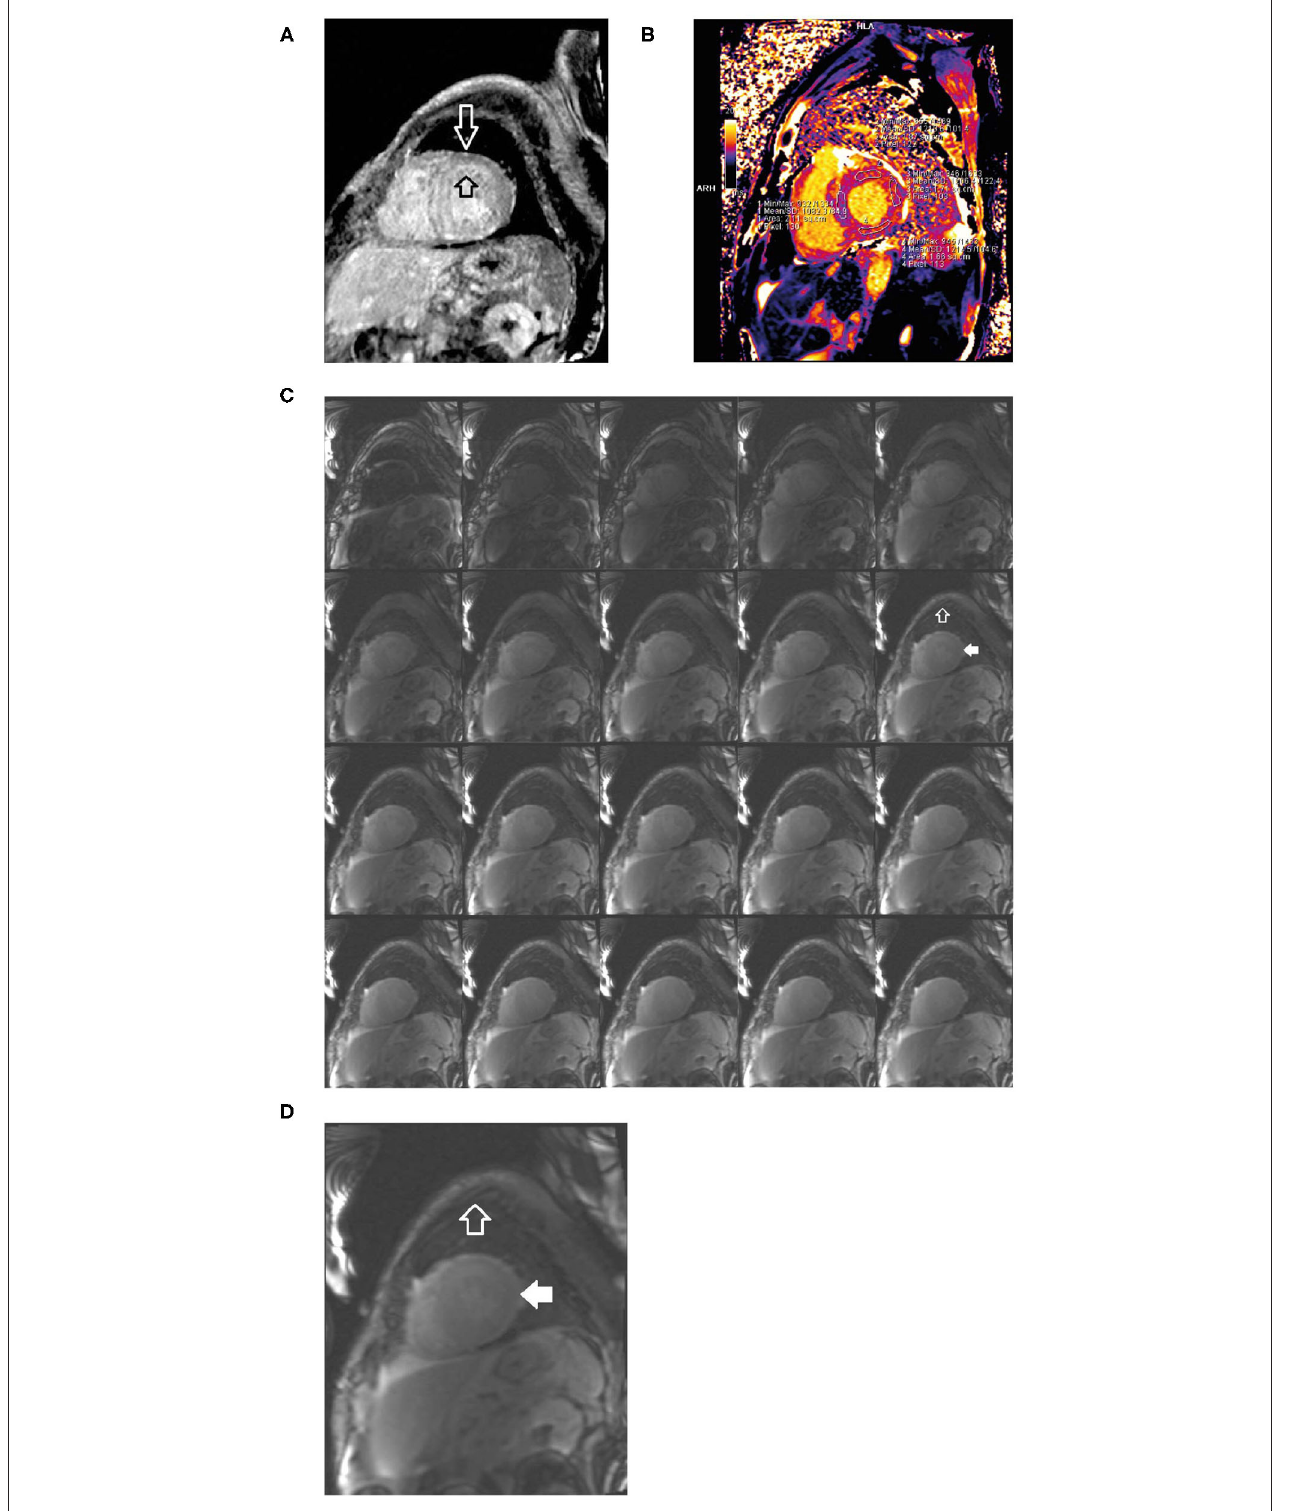
FIGURE 9 | Short axis delayed enhancement MRI (A) demonstrates diffuse late enhancement of the circumferential hypertrophic left ventricle in a characteristic decreasing gradient from endocardium to epicardium (open black and white arrows). Cardiac MRI T1 mapping (B) shows increased T1 signal and ECV consistent with infiltration. Short axis composite layout of inversion time scout imaging (C) of the left ventricle, enlarged image (D) . In comparison to skeletal muscle (open white arrow), the myocardium is difficult to null (solid white arrow) because of the lack of normal (unenhanced) myocardium. The accumulation of the amyloid protein into which the gadolinium contrast equilibrates from the blood pool. ECV, extracellular volume; MRI, magnetic resonance imaging.